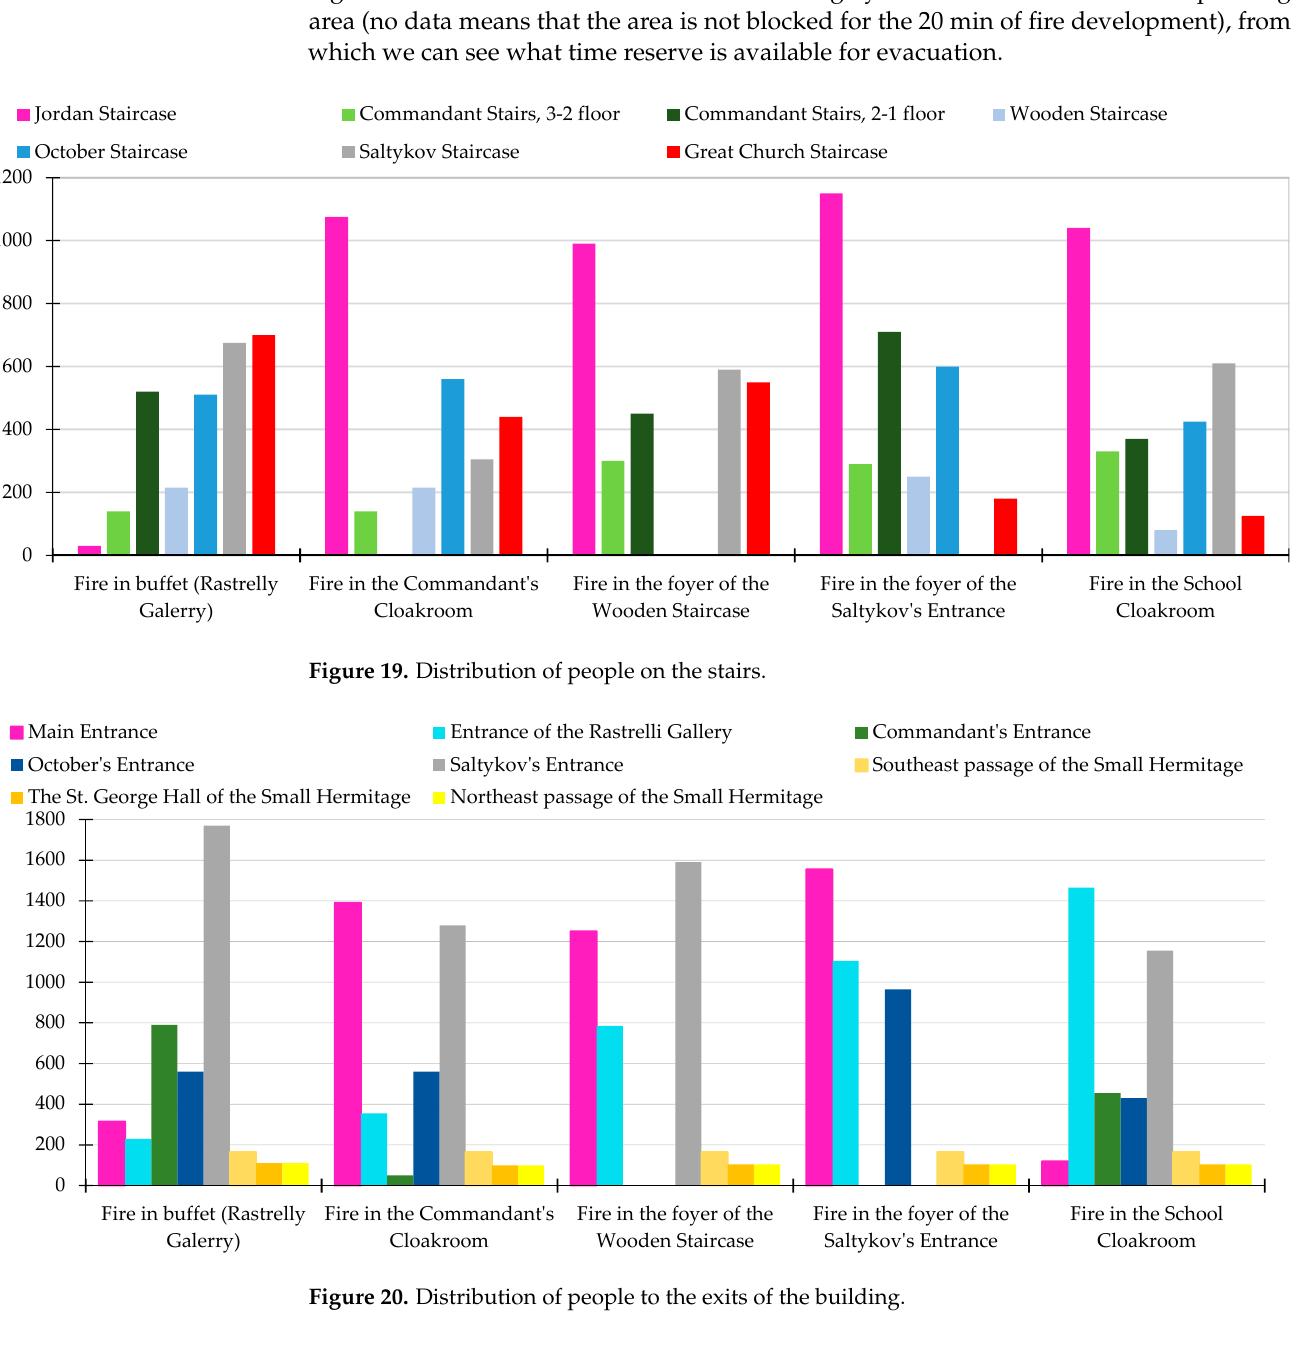
Figure 21. Evacuation time by stairs.